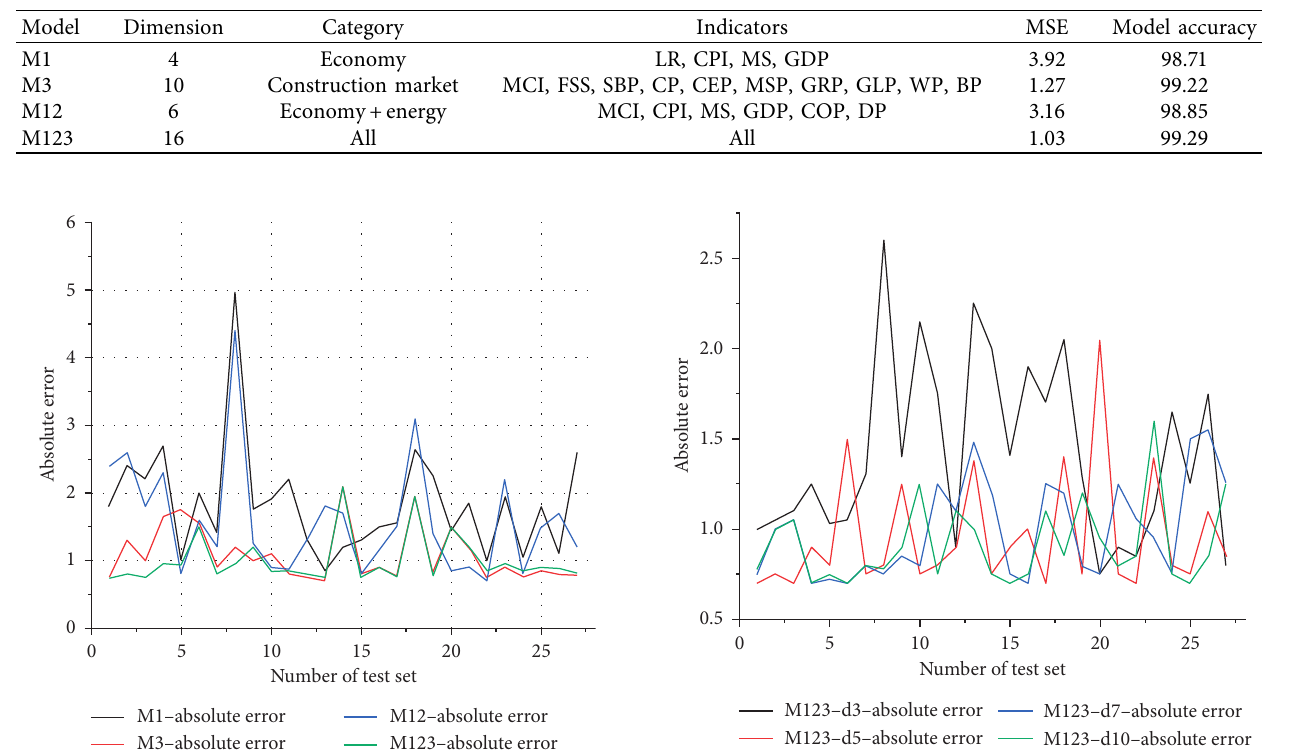
Table 5: Effects of the input features on the model’s accuracy.